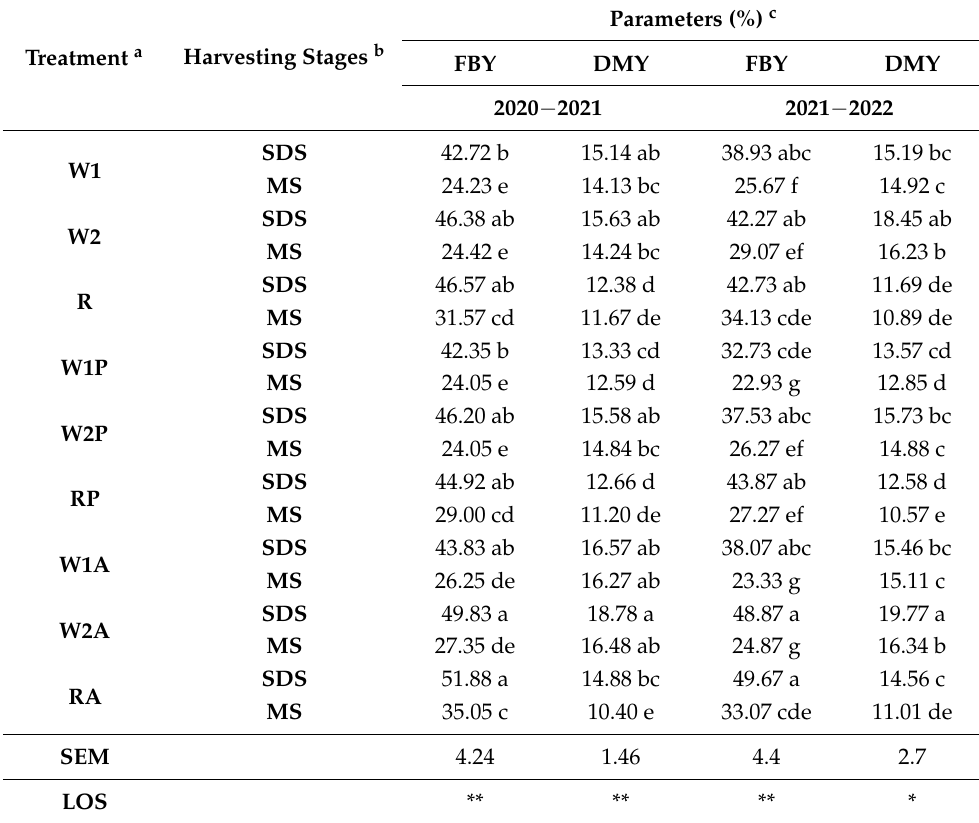
Table 4. Fresh biomass yield and dry matter yield of forage of cereal mono-cropping and cereal– legume mixed cropping during 2020 − 2021 and 2021 − 2022 growing